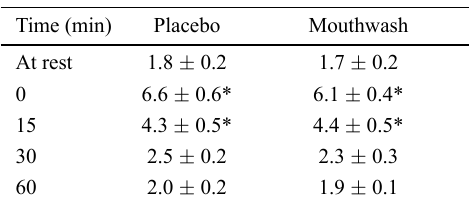
Table 2. Blood lactate (mmol/L) measured before and after